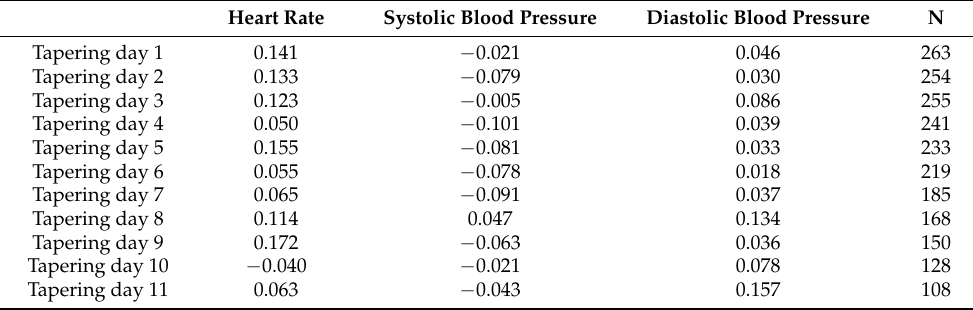
Table A3. Daily average objective withdrawal symptoms correlated with